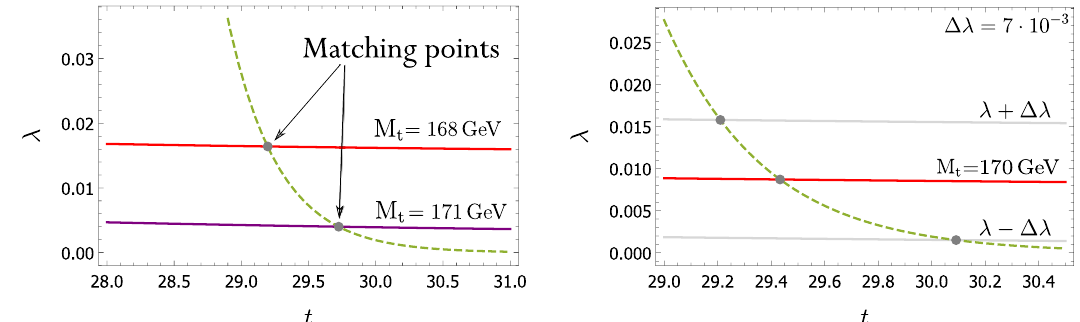
(a) RG improved potentials as a function of the canonical in(cid:13)aton (cid:12)eld h . The left (right) vertical lines correspond (for each scenario) to the beginning (end) of in(cid:13)ation.